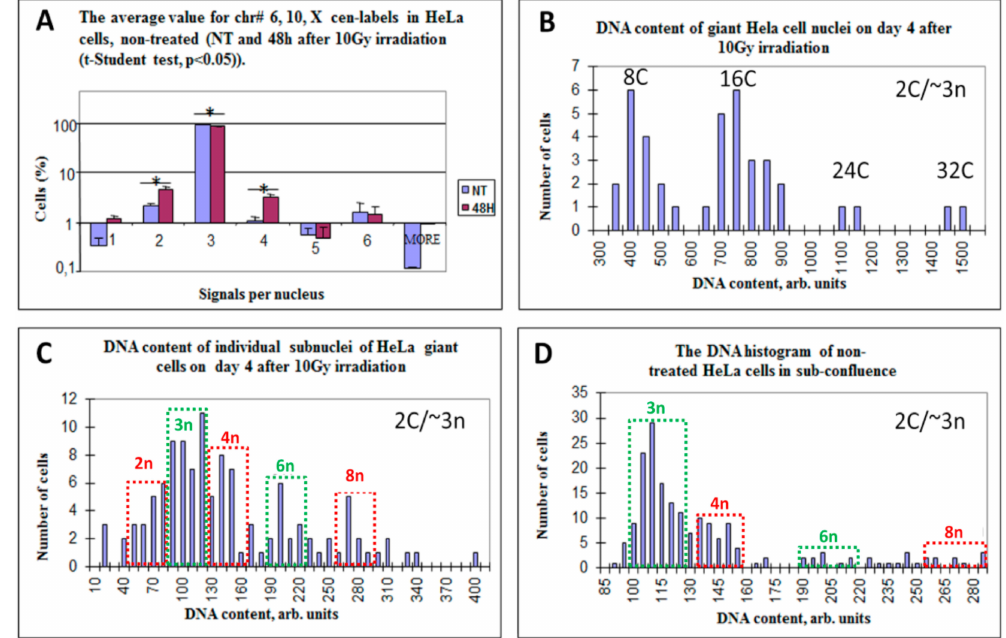
Figure 3. Endoreduplication and emergence of diploidy in the near-triploid HeLa cell line after 10 Gy-irradiation. ( A ) The decrease of the proportion of triploid nuclei and a corresponding increase of the proportion of diploid and tetraploid cell nuclei are presented as an average value for chr #6, #10, #X cen-labels in non-treated controls and 48 h after irradiation ( t -student-test, p < 0.05). Percentage of cells is presented in logarithmic scale. ( B ) DNA content (presented as integrated optical density in arbitrary units) in giant cell nuclei on day four post-irradiation. The ploidy of 2C, roughly corresponding to ~3n, was determined from anaphase halves of bipolar mitoses of the control ( n = 50). ( C ) Heterogeneity of the giant cell sub-nuclei on day four post-irradiation (obtained from 116 giant cells as determined by DNA cytometry, and expressed and converted for convenience into ~ploidy numbers showing triploid (3n) and hexaploid (6n) nuclei along with about 50% of diploid nuclei and their multiples (2n, 4n, 8n); ( D ) Non-treated HeLa cells harvested in sub-confluence, composed of the dominant 3n stemline, while the diploid stemline endocycling to 8n is also seen (mostly accumulated in the 4n-fraction). On ( C , D ), the diploid endocycling stemline fractions are enframed in red, while triploid, in green dashed